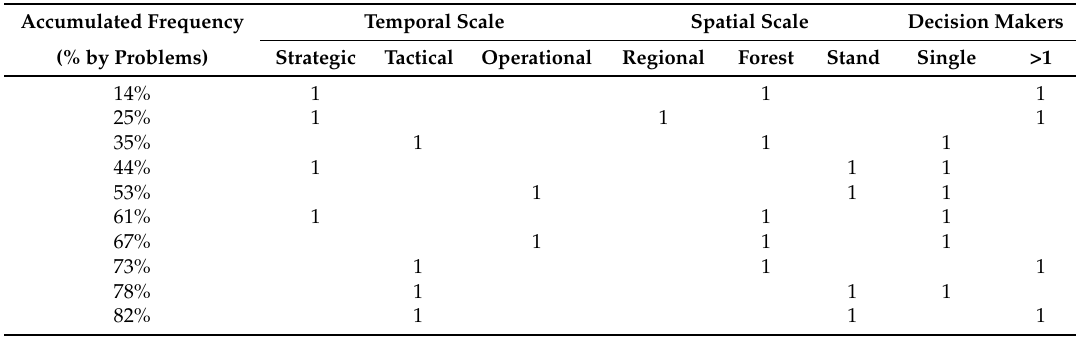
Table 4. The most frequent problem types, based on temporal and spatial scales and the number of decision makers, ordered by decreasing frequency.